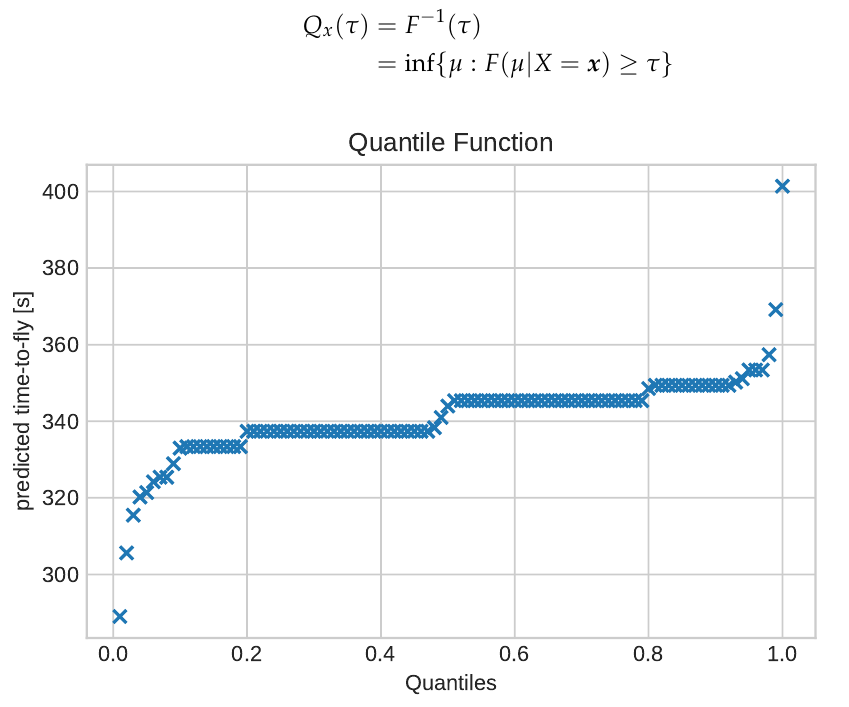
A quantile function constructed from the responses at 100 collocation points ( τ ∈ { 0.01,0.02,0.03, . . . ,1.00 } ) as given by the QRF